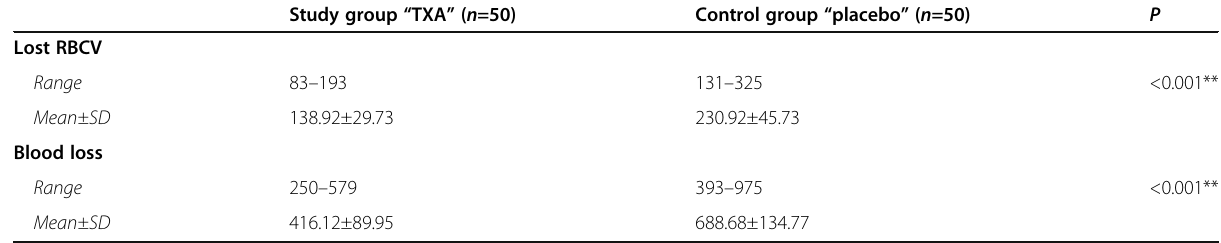
Table 4 Lost RBCV and blood loss Study group “ TXA ” ( n =50) Control group “ placebo ” ( n =50) Lost